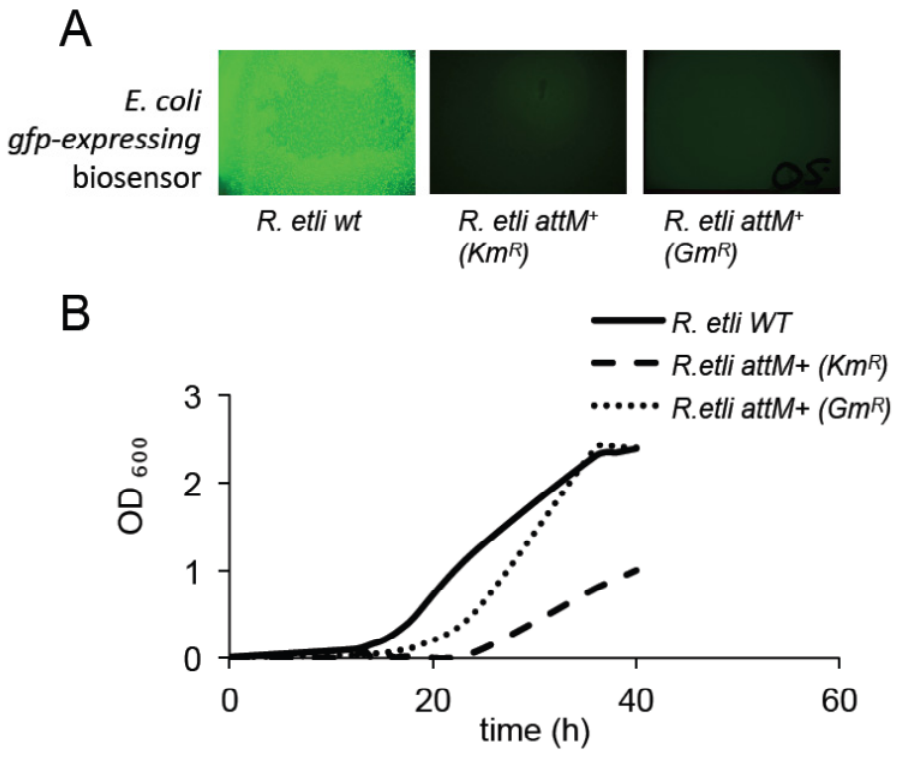
Figure S2. Production of AHL in R. etli s trains used in this work. Different strains of R. etli were tested for AHL production using the bacterial biosensor E. coli MT102 (pJBA89) ( A ) AHLs produced by the indicated R. etli strains were extracted with CHCl and applied onto a lawn of the E. coli biosensor . The GFP signal was observed 2 h thereafter. R. etli attM + (Km R ) and R. etli attM + (Gm R ) are strains expressing the attM gene from A. tumefaciens coding for a lactonase; ( B ) Growth curves of the R. etli strains. Bacteria were grown in 5 mL culture with constant agitation (100 rpm) at 21 °C. OD was measured every 4